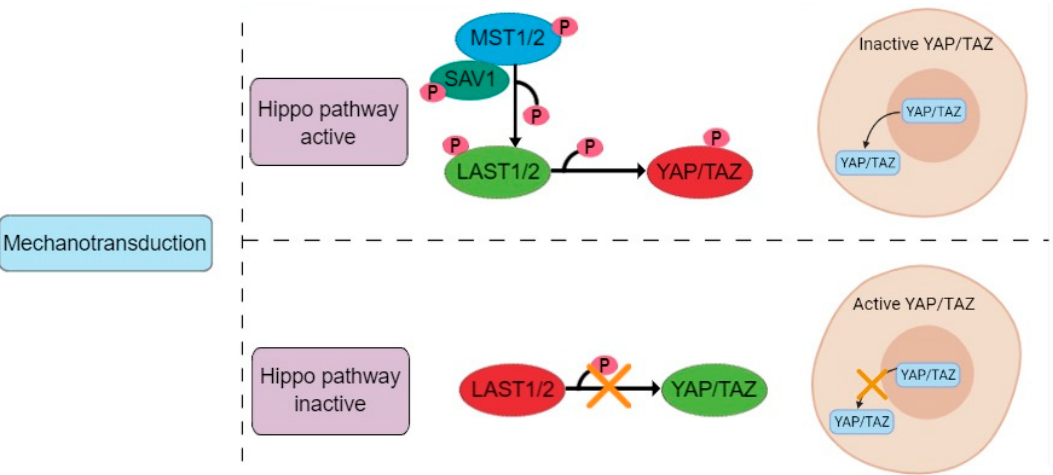
Figure 11. Hippo pathway regulation of YAP/TAZ. The interaction between MST1/2 and SAV1 leads to phosphorylation of LAST1/2, which are activated and phosphorylate YAP, causing its translocation outside the nucleus and cytoplasmic retention.